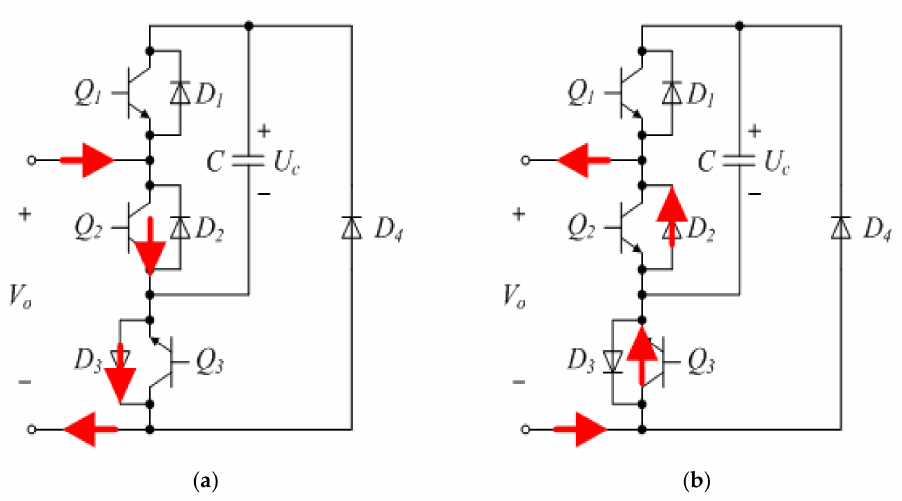
Figure 3. Current path of CSSM in the case that the submodule is disconnected to the converter in normal operation mode: ( a ) Q2 = ON; ( b ) Q3 =